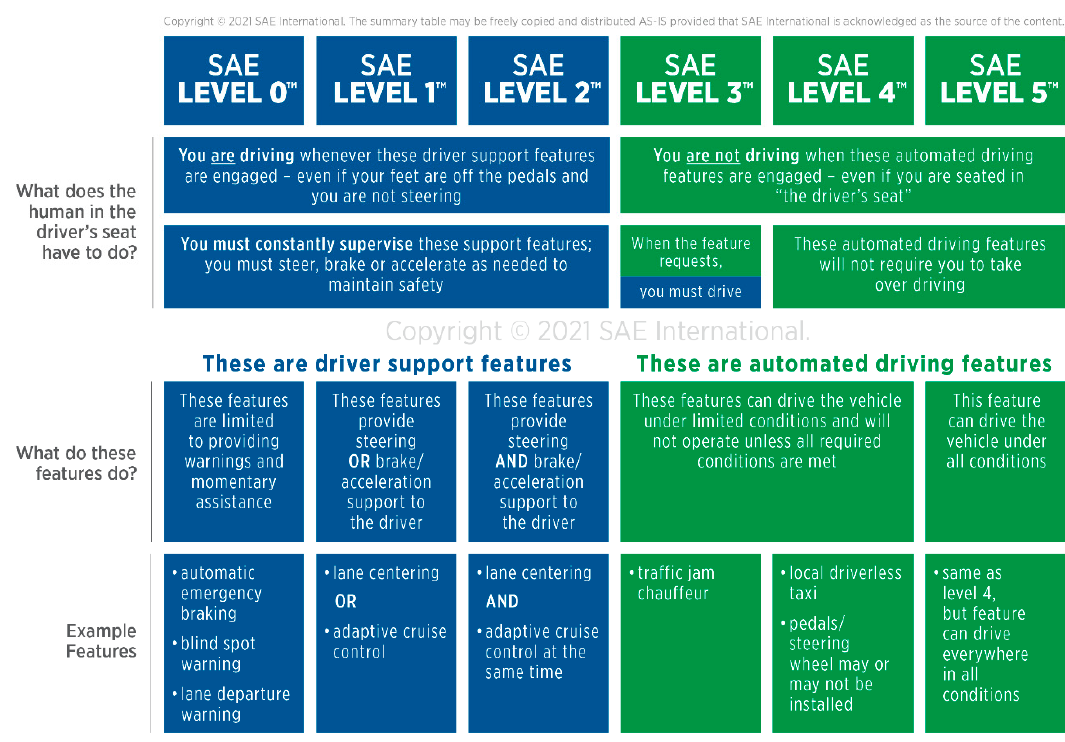
Figure 1. The six levels of driving automation [SAE J3016 TM LEVELS OF DRIVING AUTOMATION TM . Copyright © 2021 SAE International].